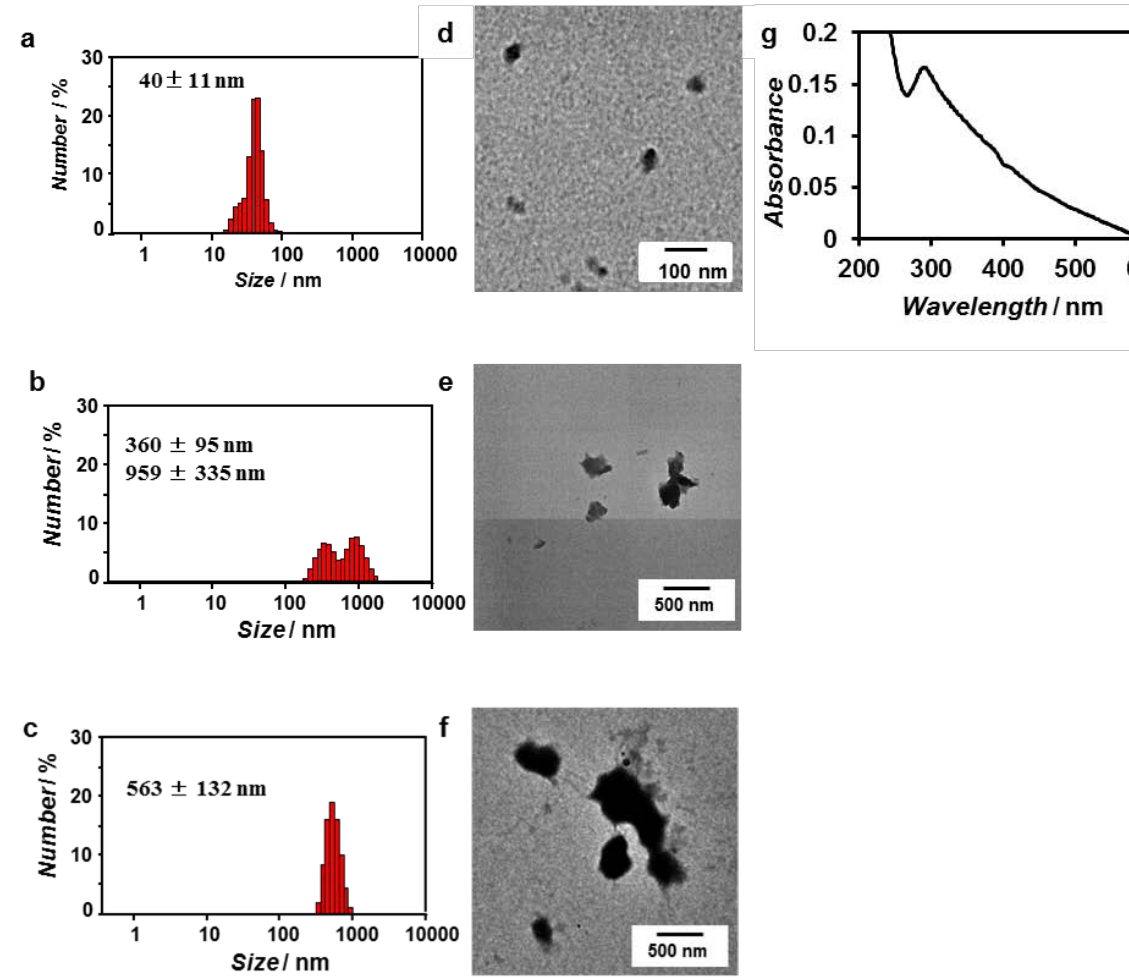
Figure 6. Size distribution obtained from DLS ( a – c ), unstained TEM image ( d – f ), and UV-Vis spectrum ( g ) of ZnO nanoparticles synthesized in the presence of peptide 1 ( a , d , g ), peptide 2 ( b , e ), and peptide 3 ( c , f ) in